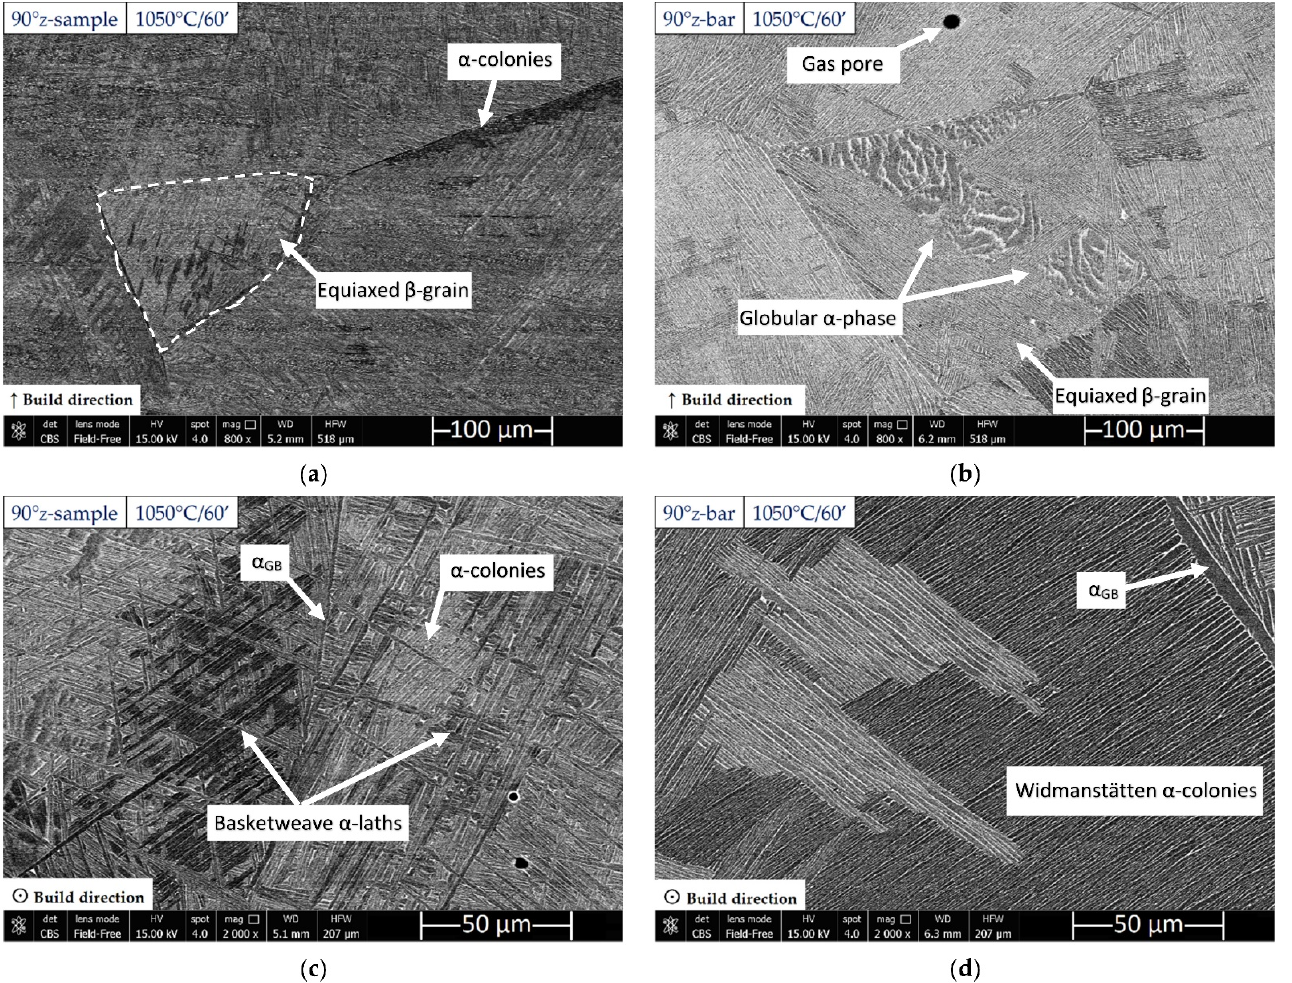
Figure 6. SEM micrographs of the 90° Z -sample ( a , c ) and the 90° Z -bar ( b , d ) acquired on the perpen- dicular ( a , b ) and parallel ( b , c ) planes to the build platform after 1050 °C/60 ′ . Heat treatment at 1050 °C/60 ′ also induces the formation of an α -case surface layer with a thickness of 100 ÷ 150 μ m and hardness of (400 ± 10) HV 0.1 in both the tensile sample (Figure 7a) and bar (Figure 7b). Similar results are shown in [49,52] for the cross-sections